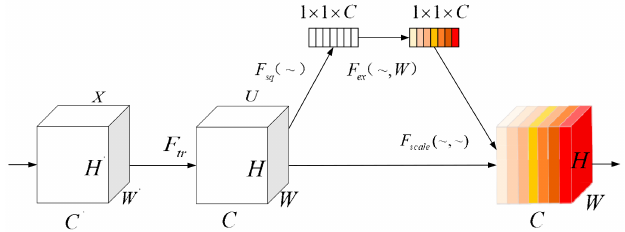
Figure 5. Schematic diagram of the structure of the SE